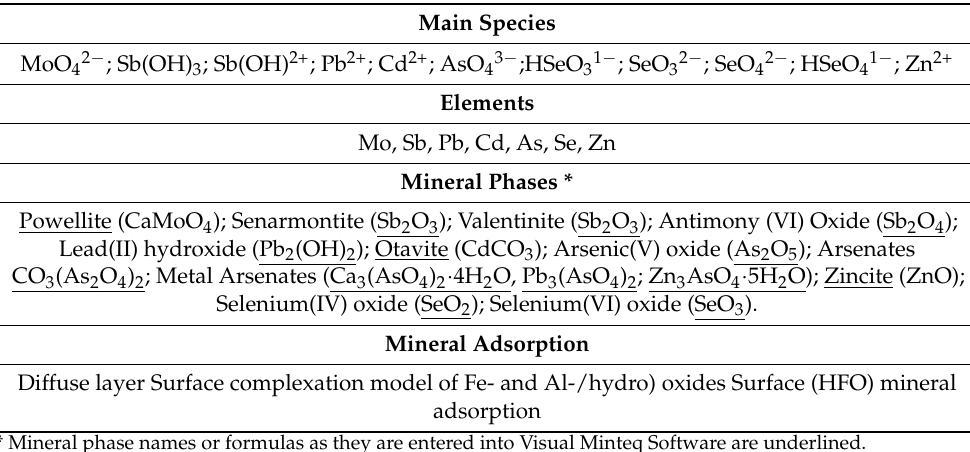
Table 3. Input parameters of the geochemical